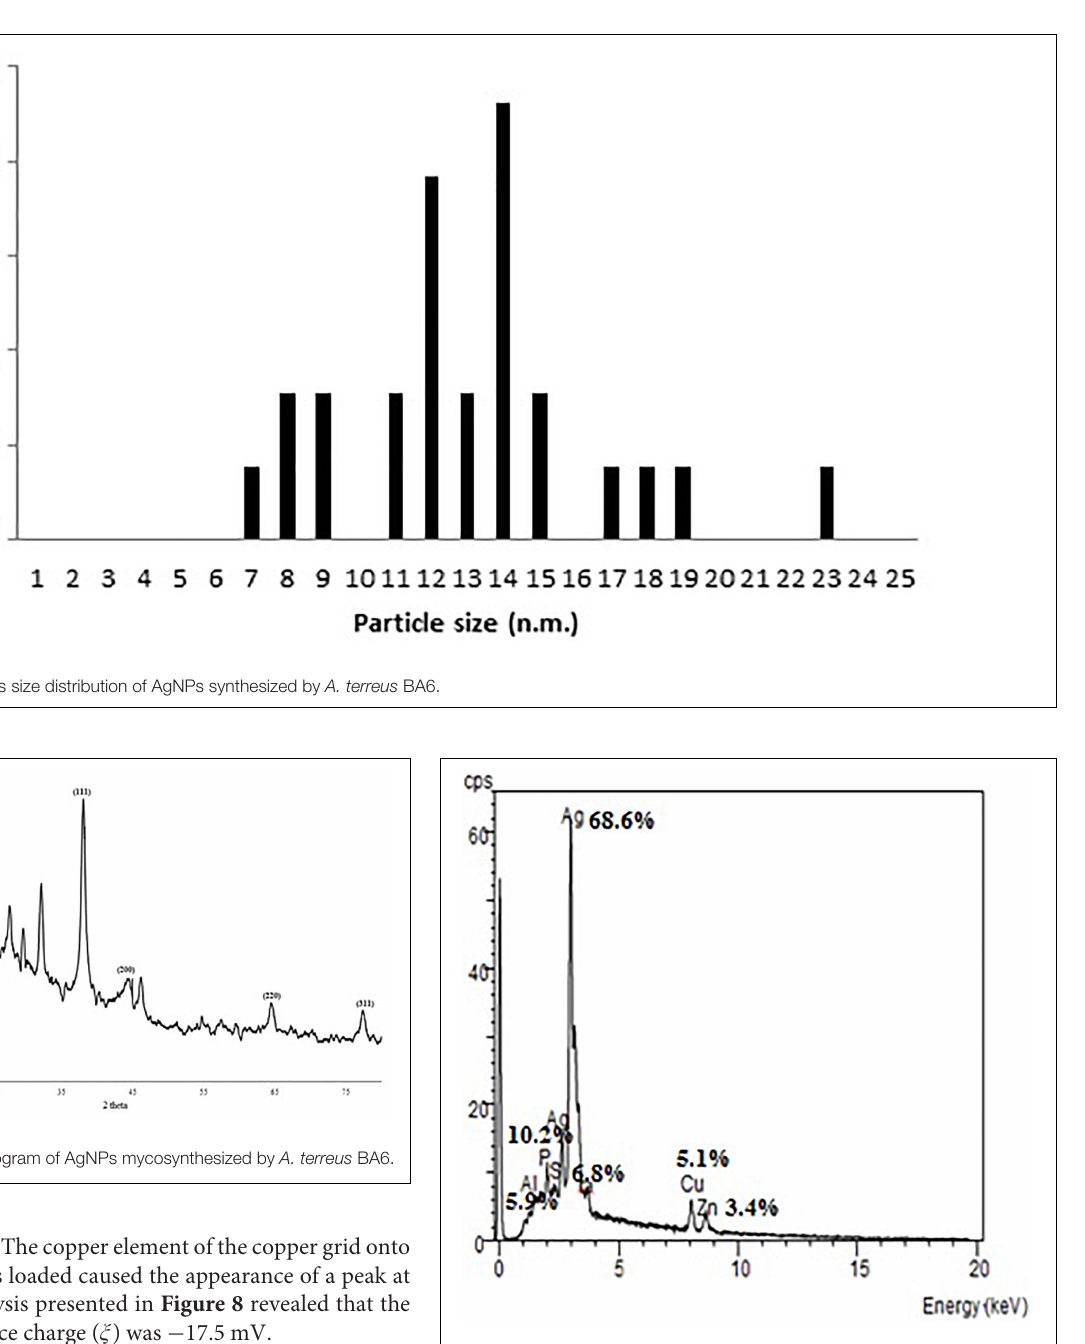
FIGURE 7 | EDX spectrum of A. terreus BA6